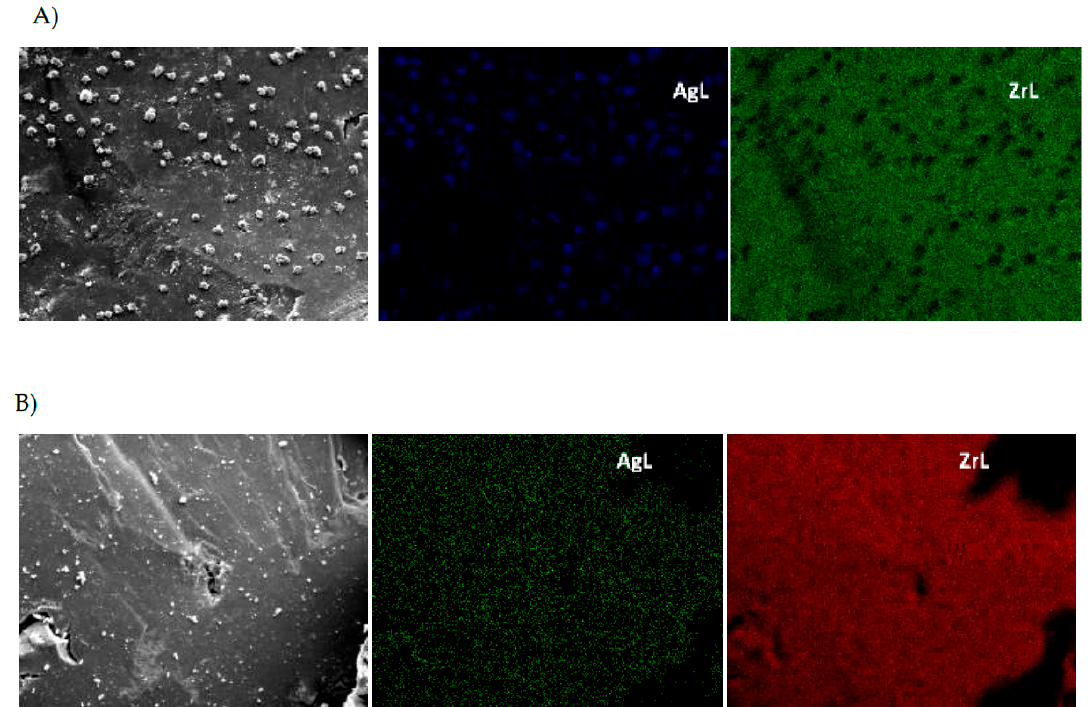
Figure 3. SEM images and elemental mapping of Ag and Zr in catalysts: ( A ) Ag5Z and ( B ) Ag10Z.